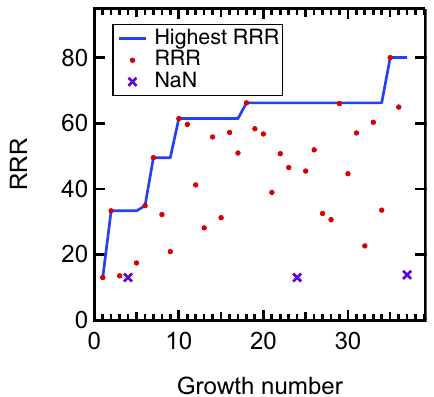
Fig. 7 ML-MBE optimization results. Highest experimental RRR and RRR values plotted as a function of the growth number. The purple crosses indicate the NaN points at which the SrRuO 3 phase was not